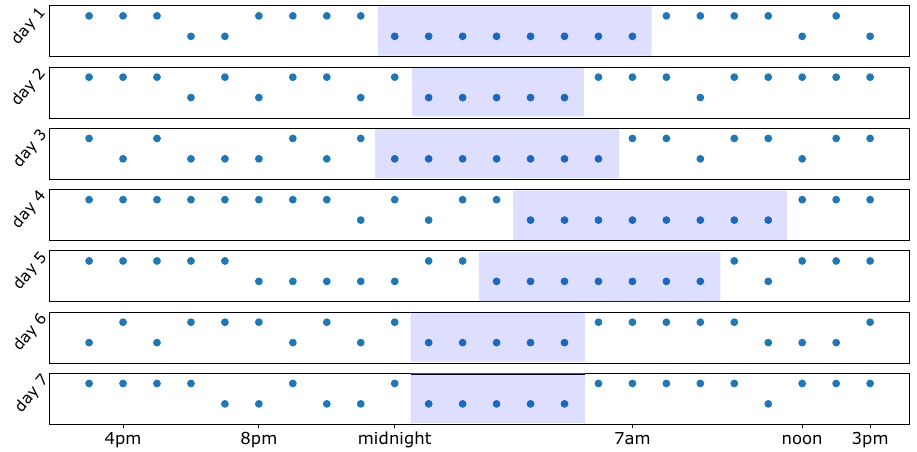
Figure 6. This figure shows presences of screen-on events in different hours and different days (each row is one day of data for 7 sample days) from one person in the study. The higher dots show presence of phone activity in that hour and lower dots show the lack of it. We find the longest period of of inactivity within the 24 h (area filled with blue). These hours are marked as sleeping times. The first hour of inactivity is recognized as (going to) “sleep time” and the first hour right after of the period of inactivity is determined to be the “wake-up time”. This processes repeated for all days for each